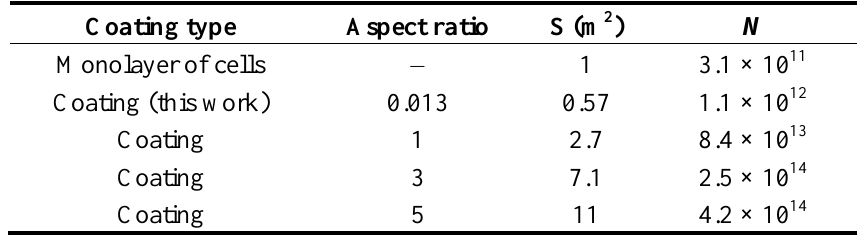
Table 2. Comparison of the theoretical surface area ( S ) and total number of G. oxydans cells ( N ) from a monolayer of G. oxydans cells [50] and an inkjet printed dot array of 250-µm diameter cylindrical dots of various aspect ratios (height/diameter). Dots are spaced 50 µm, and the surface of the substrate is 1 m 2 . Calculations were carried out assuming a G. oxydans cell size of 0.8 µm × 4 µm and using a cell concentration in the coating of 0.62 cells/µm 3 (Table